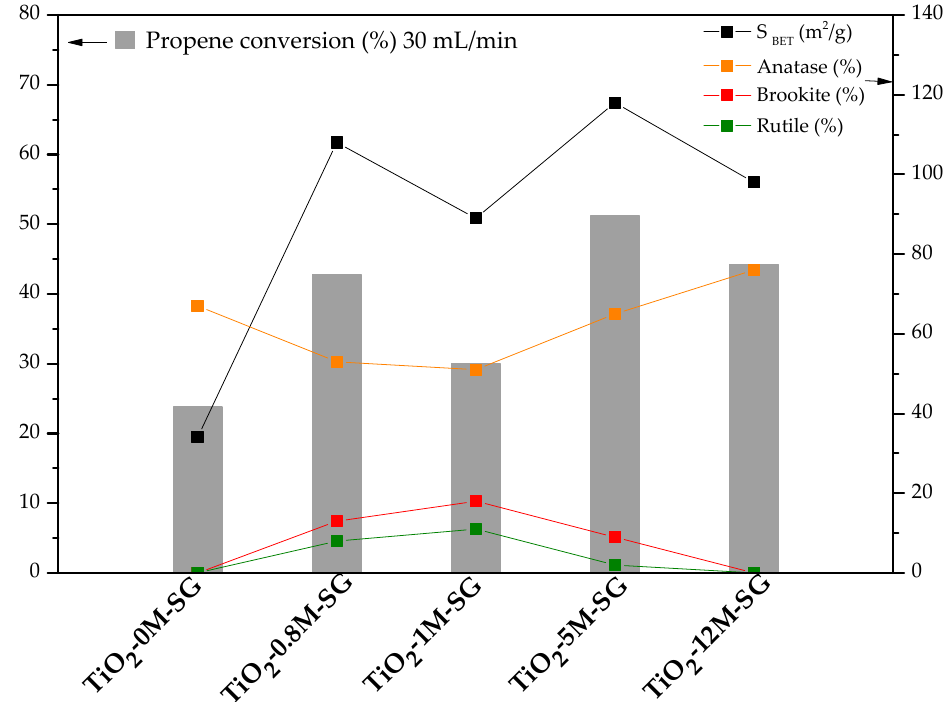
Figure 7. Propene conversion (using 30 mL/min gas flow), surface area and weight percentage of each crystalline phase in the SG photocatalysts.